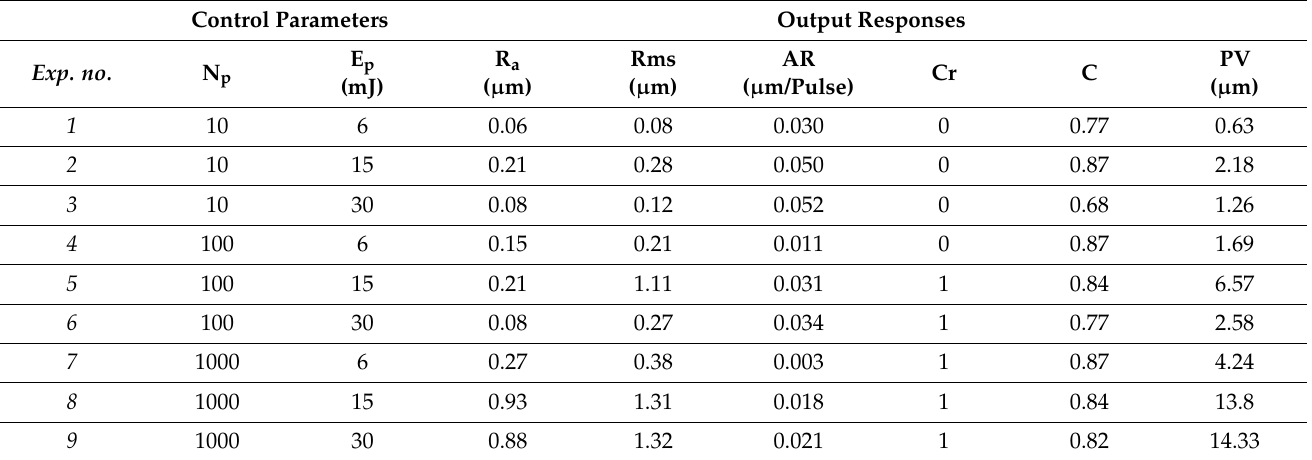
Table 4. Experimental observations for argon-enriched